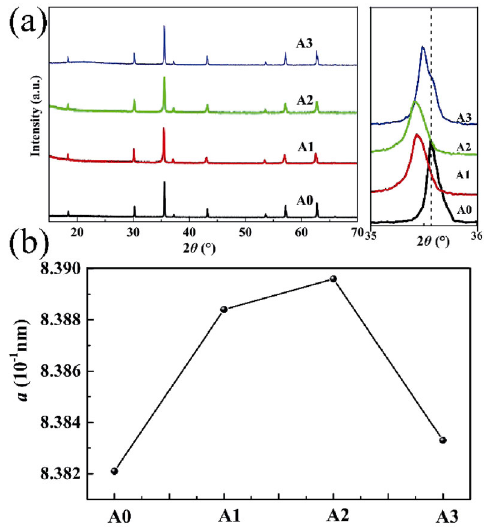
Fig. 4 (a) XRD patterns and (b) lattice parameters of A0, A1, A2, and A3 ceramics after sintering at 1175 ℃ .